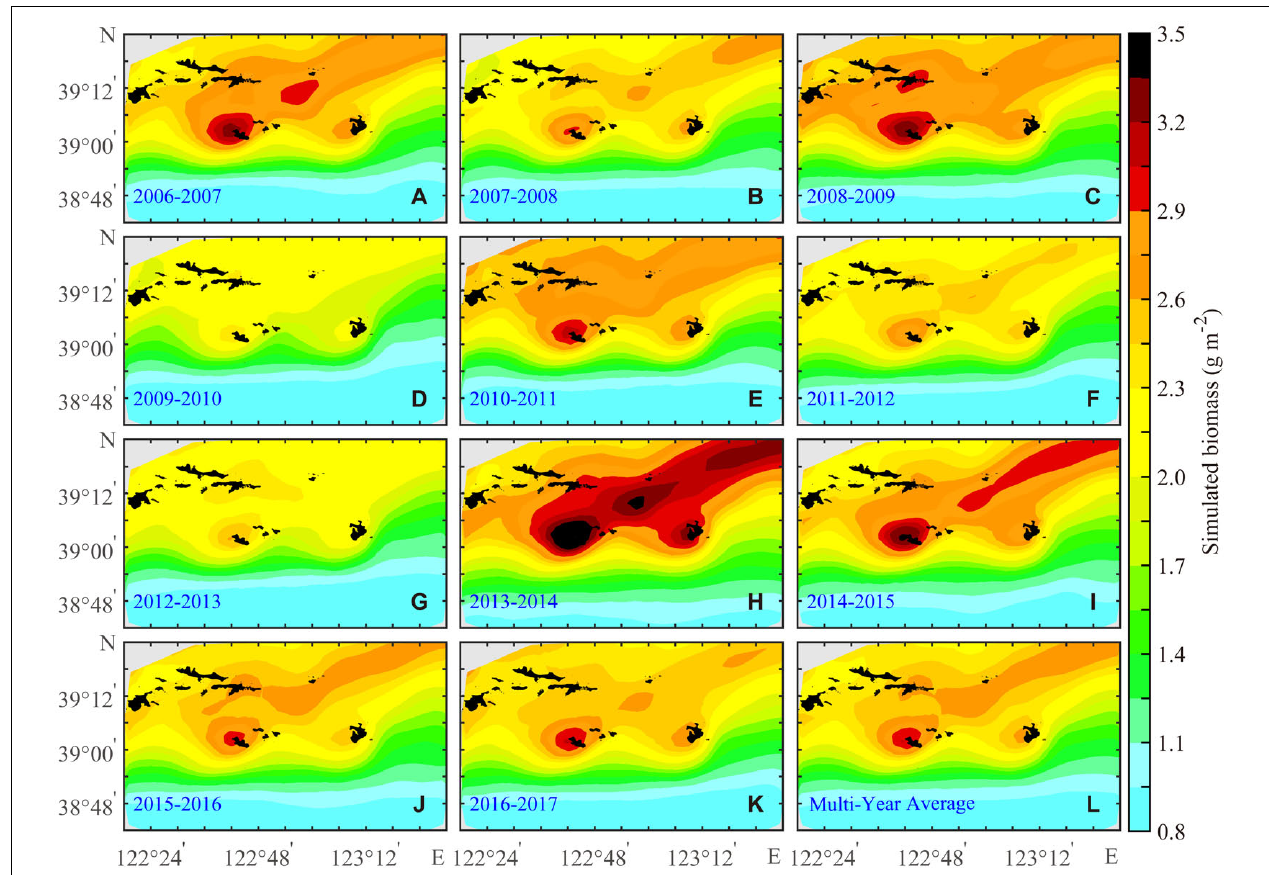
FIGURE 3 | Annual (A–K) and the multiyear average (L) of the bottom-cultured Yesso scallop ( P. yessoensis ) biomass in the Changhai sea area, China, from December 1, 2006 to November 30, 2017.